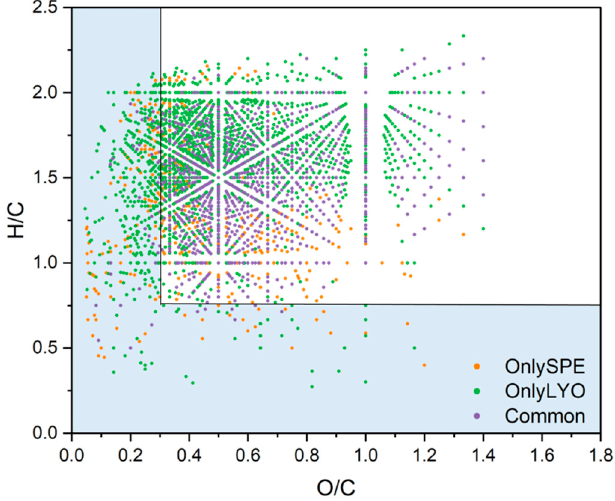
Figure 6. Van Krevelen diagram of the MFs in common between the LYO and SPE (“Common”) in violet, those only present in the SPE extract (“OnlySPE”) in orange, and those only present in the lyophilized extract (“OnlyLYO”) in green. Data treatment was conducted with MFAssignR.